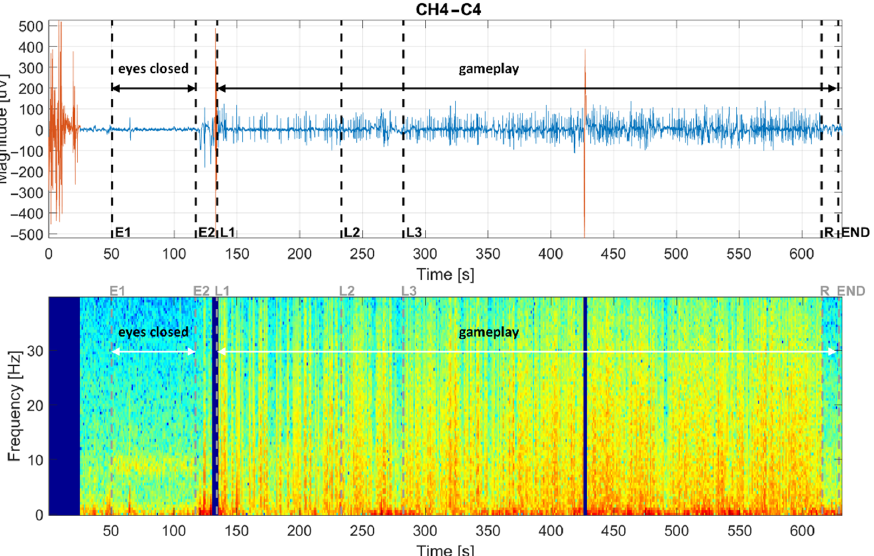
Figure 5. The raw EEG signal from the C4 channel ( top ) and corresponding spectrogram ( bottom ) of the subject no. 1. the subject no.